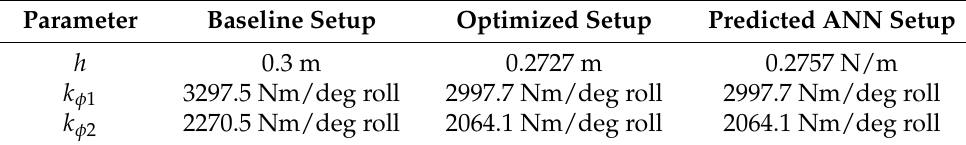
Table 5. Comparison between the baseline, optimized and predicted ANN